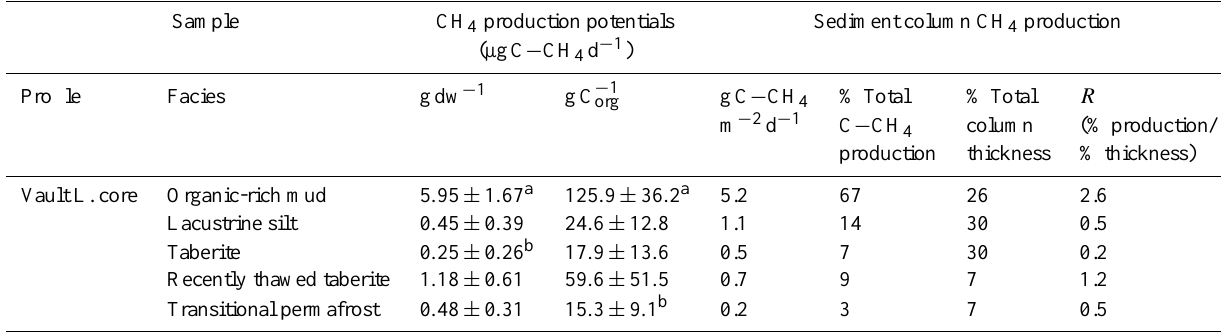
Table 5. Summary of facies’ CH 4 production potentials and depth-integrated CH 4 production for the total sediment column. Data are presented as mean ± SD. It should be noted that, based on optical properties (Fig. 2), dry bulk density (mean ± SD, 1 . 31 ± 0 . 07gcm − 3 ), gravimetric moisture content (29 ± 0 . 00%), and C org (1.64%) values measured on two samples in the depth interval 77–97cm of the core, which were similar to those of Lacustrine Silt and very different from the remainder of the Organic-rich mud facies segments, we applied CH 4 production rates measured on Lacustrine silt samples to this 21cm interval of the Organic-rich mud section. This was done because no samples from this 21cm thick, mineral-dominated segment of organic-rich mud were represented in the incubation. Sample